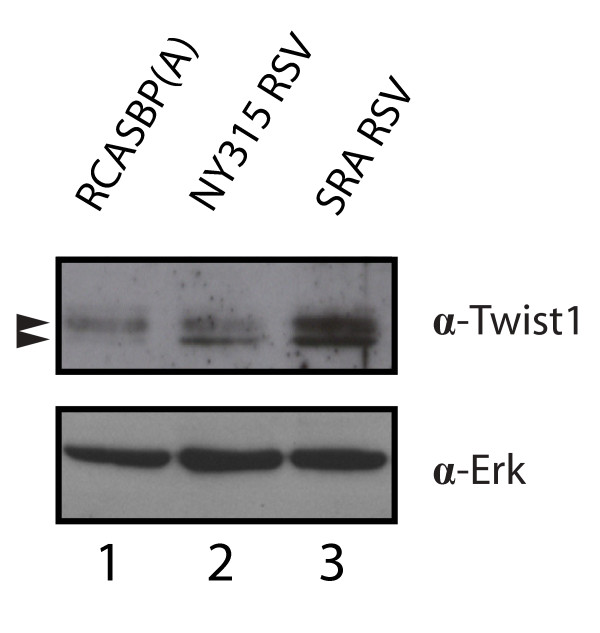
Up-regulation of Twist1 in v-Src-transformed CEF. Twist1 protein levels are up-regulated in v-Src transformed CEF. Two Twist1 immunoreactive protein species of 26 kDa of molecular weight are detected in normal and v-Src transformed CEF.